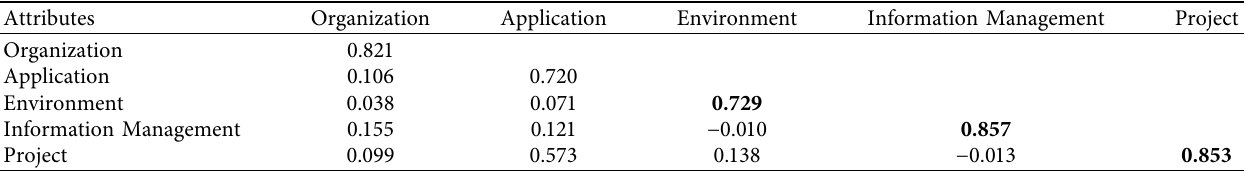
Table 7: Interconstruct correlation (discriminant validity) for public infrastructure projects.